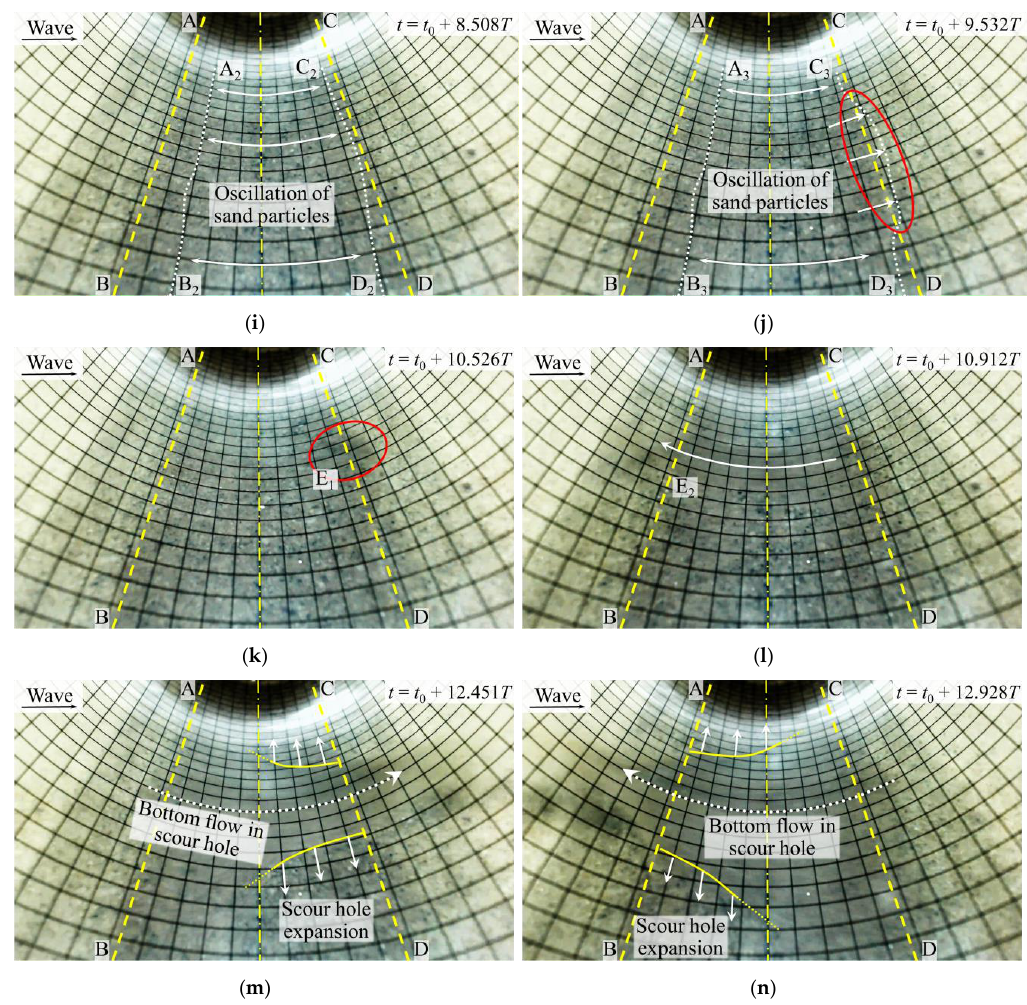
Figure 5. Process of the onset of scour ( a ) t = t0 = 31.100 s; ( b ) t = t0 + 0.505T; ( c ) t = t0 + 1.138T; ( d ) t = t0 + 1.528T; ( e ) t = t0 + 1.972T; ( f ) t = t0 + 2.481T; ( g ) t = t0 + 2.899T; ( h ) t = t0 + 6.522T; ( i ) t = t0 + 8.508T